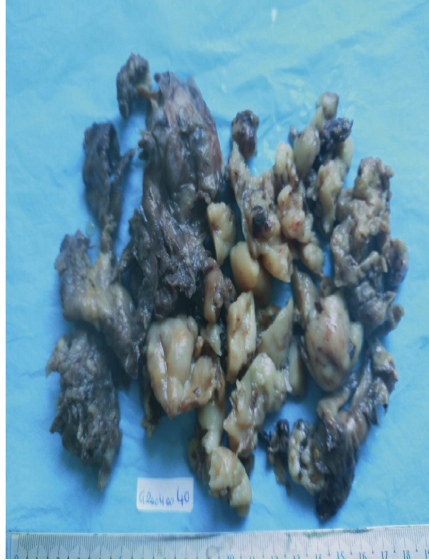
Figure 3: Multiple resected fragments with a gelatinous component with necrotic fragments.